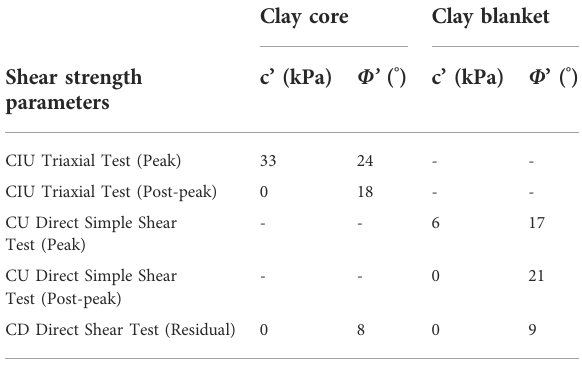
FIGURE 8 Normalized stress-displacement behavior of CB clay core samples from direct shear tests.